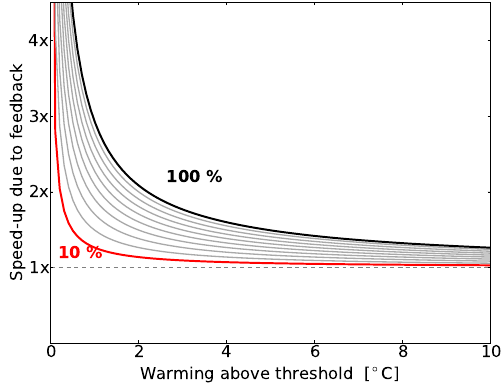
Figure 5. Role of melt elevation feedback in melting of Greenland Ice Sheet declines with increasing temperature. Shown is the ratio of melt time with melt elevation feedback over melt time without the feedback τ α /τ 0 . Each line represents the ratio for a loss of different percent of the initial ice volume. The red line shows the ratio of the decay time with feedback over the decay time without feedback for a 10% ice loss (corresponding to Figs. 2 and 4). The influence of the feedback becomes less dominant with stronger warming above the critical threshold ( x axis). Near the threshold the melt time without feedback diverges stronger (1 /(cid:49)T ) than the melt time with feed- back which declines